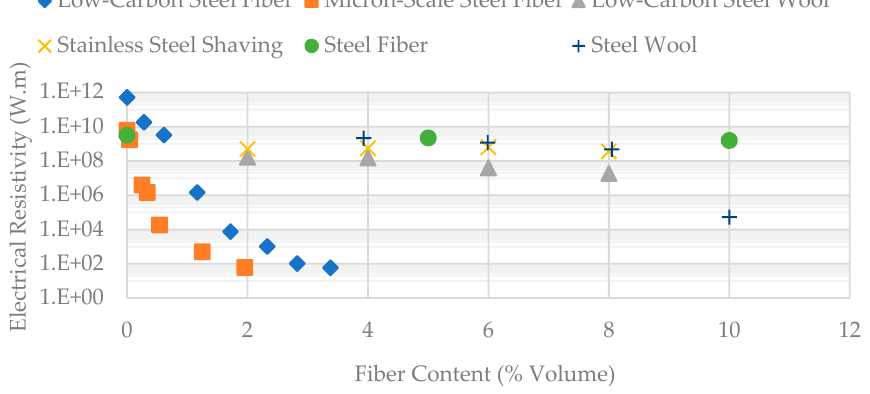
Figure 1. Selected experimental data on fiber content and electrical resistivity. Table 1. Selected experimental studies on the electrical resistivity of fiber-reinforced asphalt.